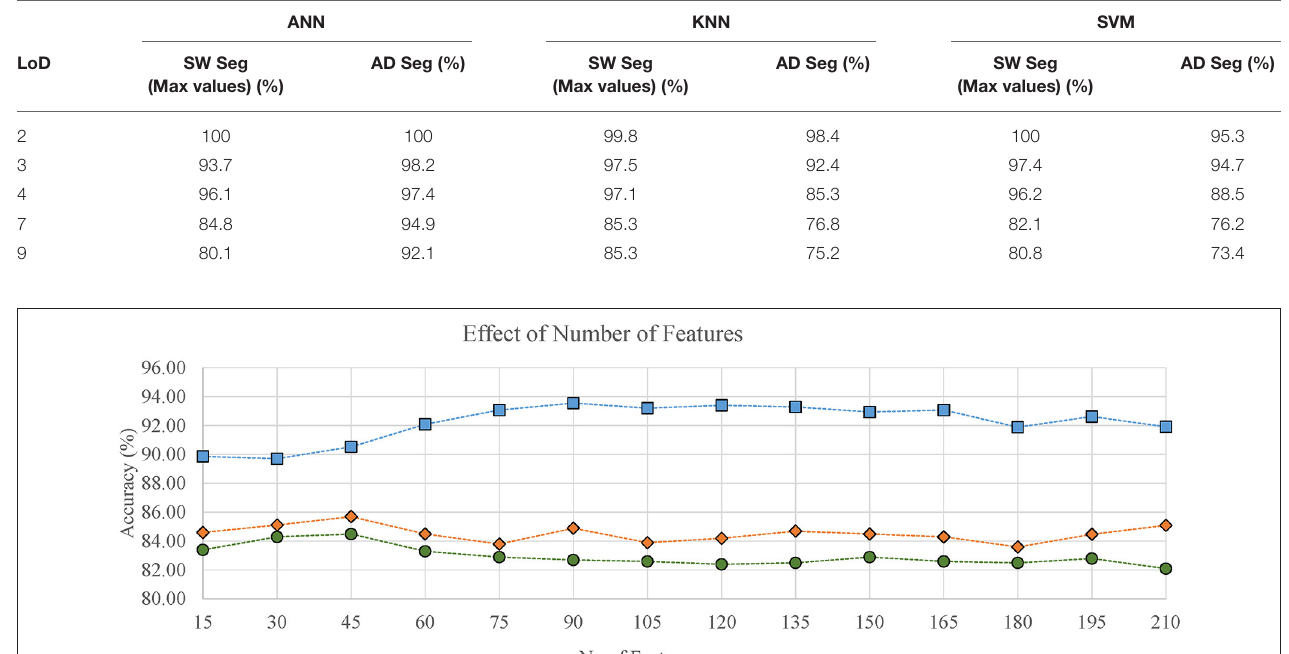
TABLE 4 | Comparative analysis between SW and AD segmentation using all three classifiers.